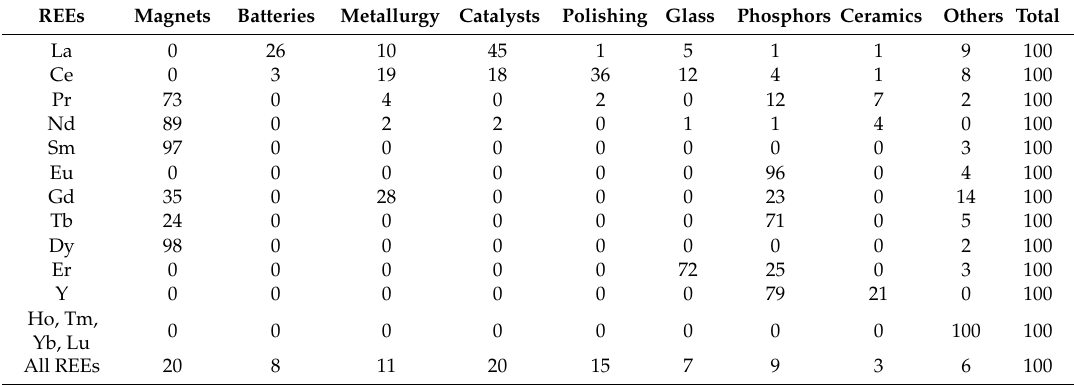
Table 2. Overview of the distribution of REEs usage (in % of rare earth oxides) in di ff erent applications, in 2012. Data source: EU report on Critical Raw Materials